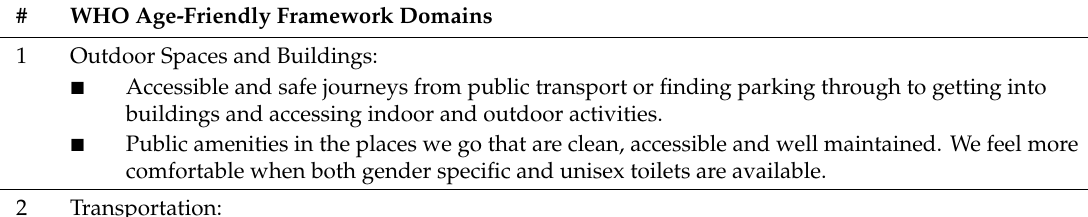
Table 3. Age-friendly Auckland Project’s Key Community Engagement Messages 1